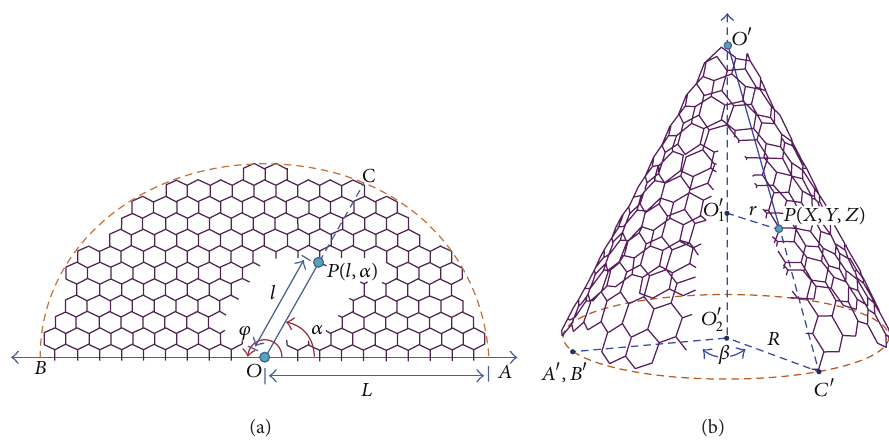
Figure 2: Symbols and variables used in the transformation from a graphene sheet for a cone 180 ∘